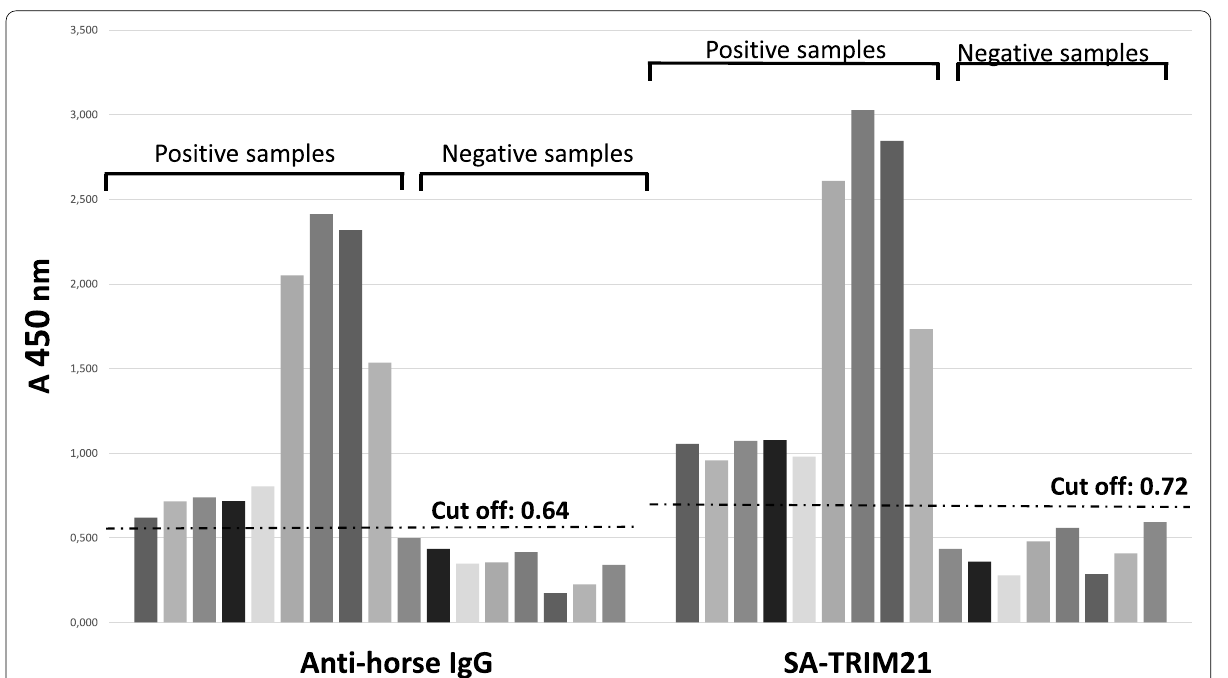
Fig. 6 Detection of anti-equine infectious anemia IgG on horse serum. Wells were coated with viral antigens, followed by incubation with horse serum samples. Wells were washed followed by incubation with HRP coupled anti-IgG or SA-TRIM21. After washing, the chromogen TMB was added to the wells followed by incubation during 10 min. Reactions were quenched using Stop solution and absorbance was read at 450